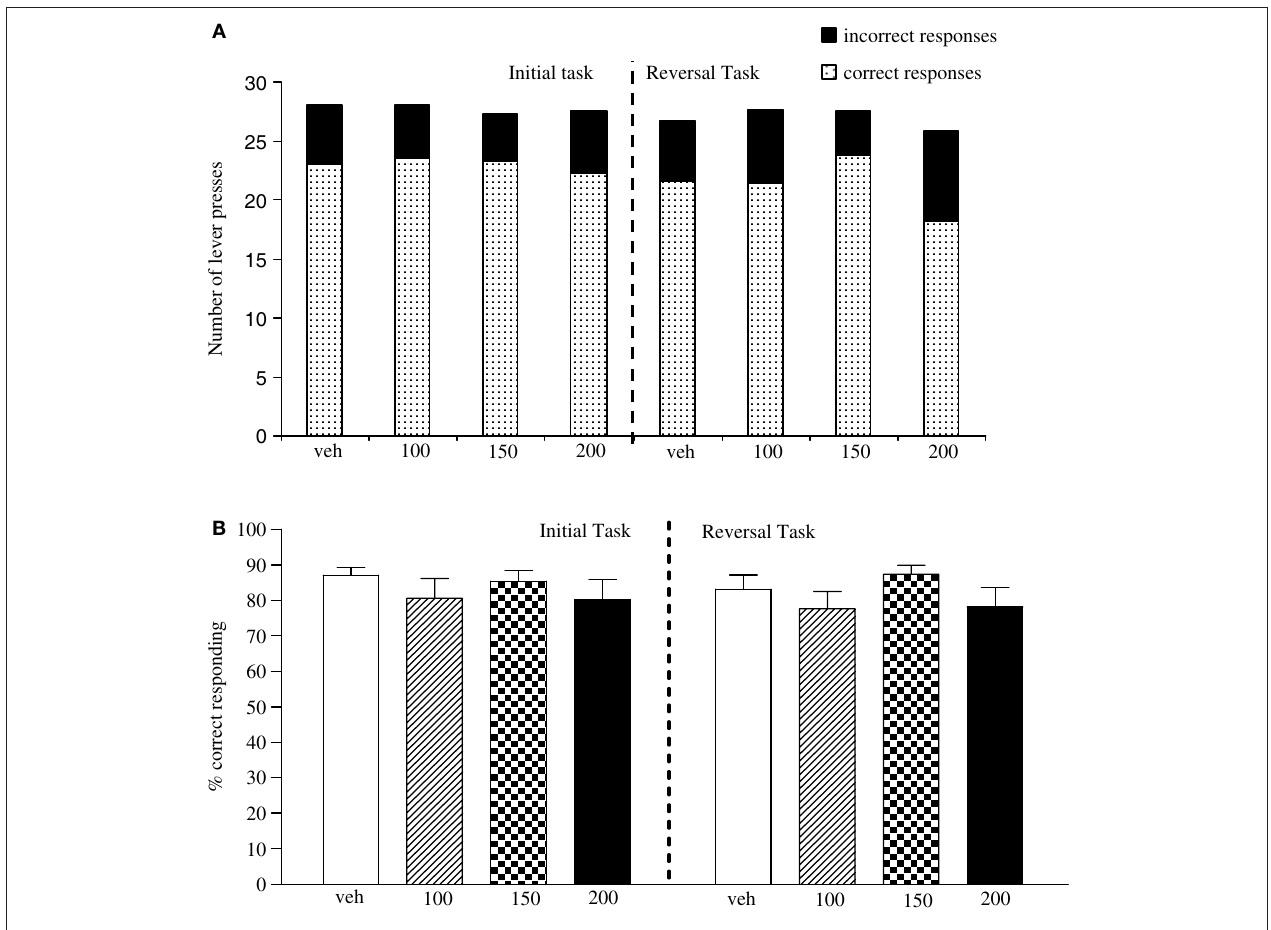
( n = 10 per group). (B) The infl uence of sodium valproate (100–200 mg/kg, i.p.) on performance of the initial and reversal phase in a reversal learning task. Data are shown as mean ± S.E.M. percentage correct responding